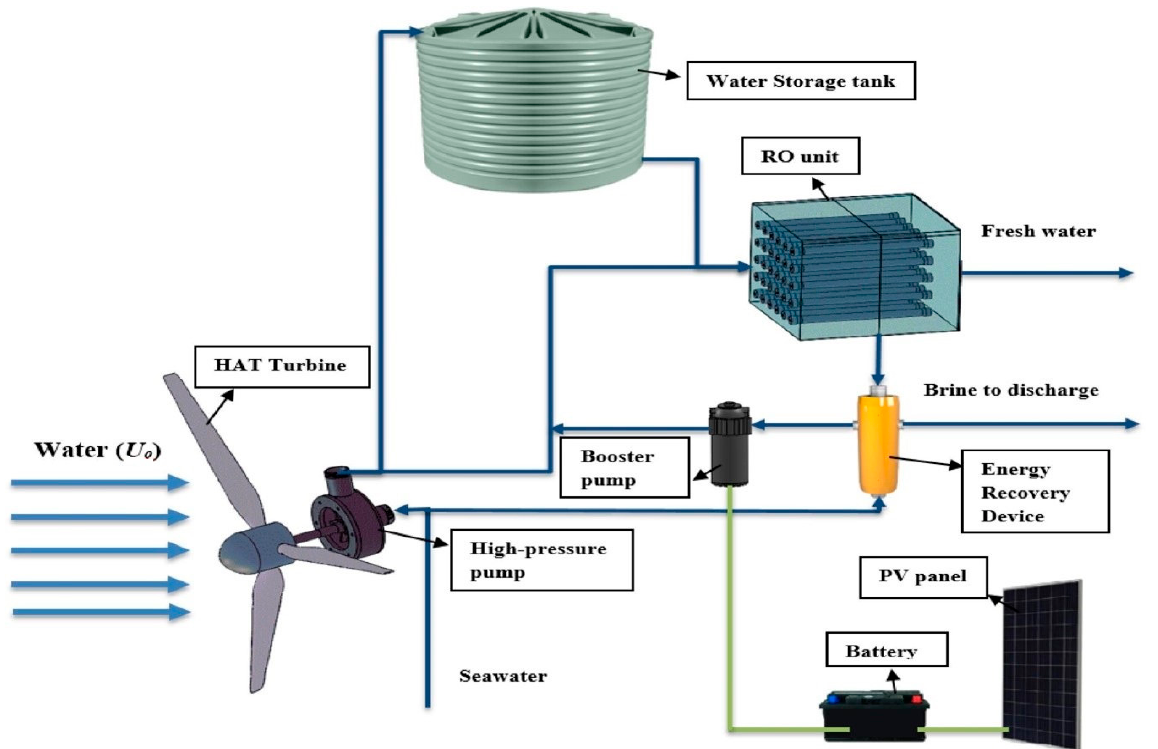
Figure 13. Hybrid tidal/PV-WDS powered by horizontal axis tidal turbines [135], reused with permission from Elsevier (license number 5491450395991).